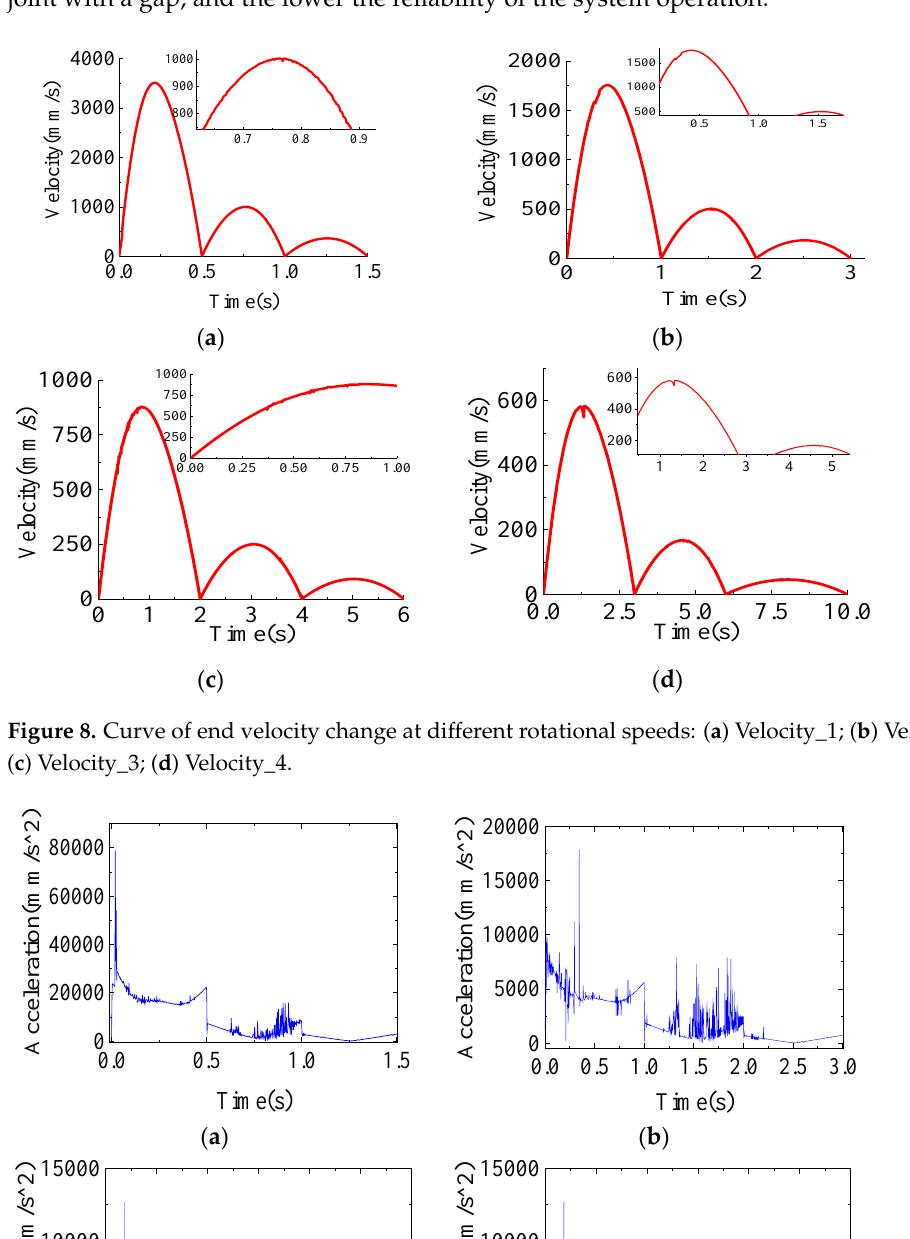
Table 2. Joint speed driving function.